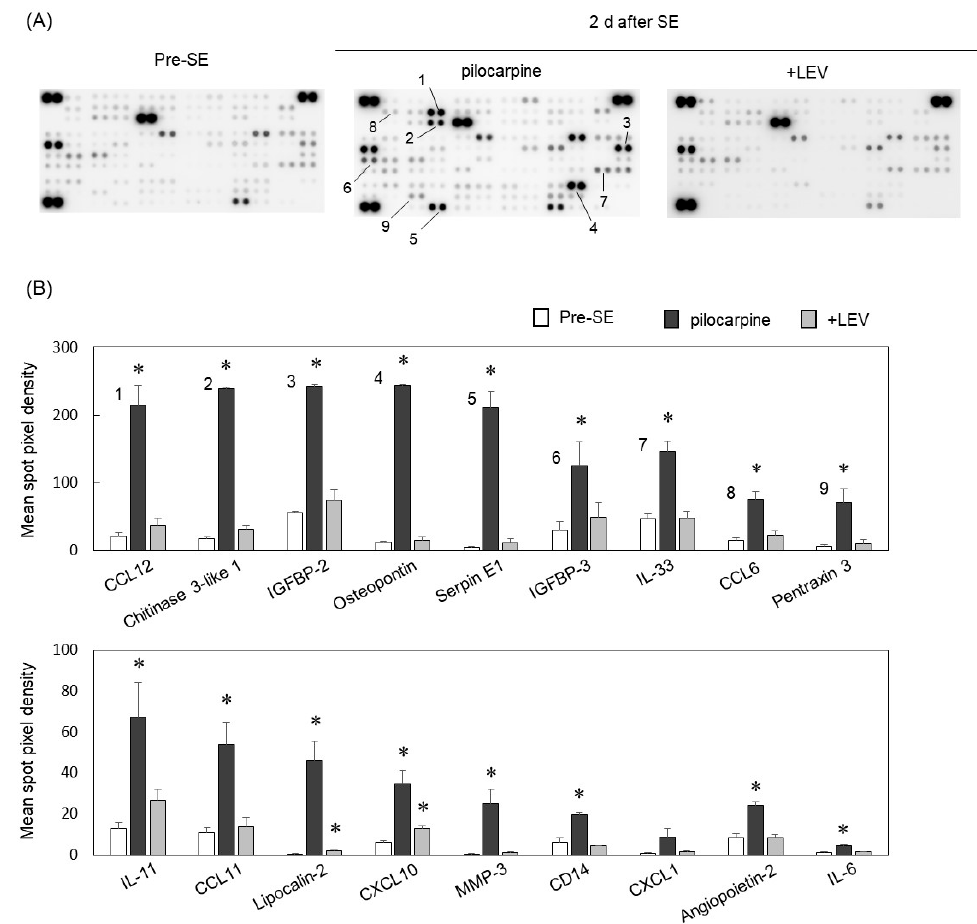
Figure 3. Proteome analysis using cytokine array. ( A ) Mice were killed 2 days after pilocarpine- induced SE. LEV was repeatedly administered for 2 days after the termination of SE by midazolam. Whole hippocampi were lysed with RIPA buffer supplemented with protease inhibitor cocktail.